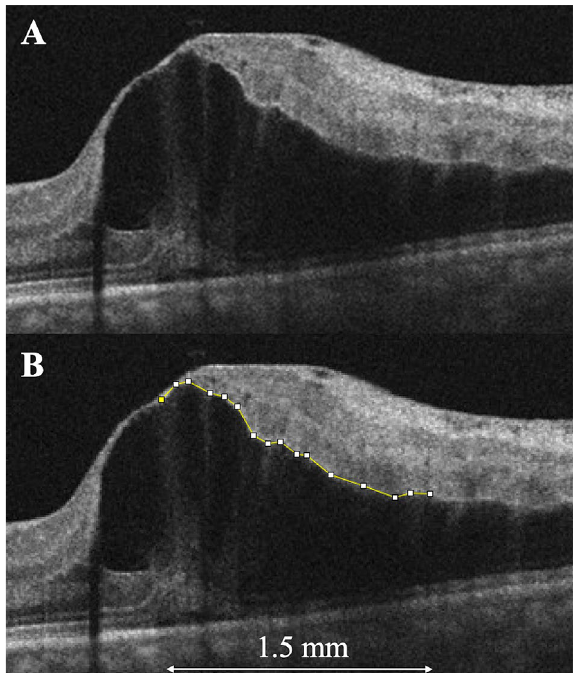
Figure 3. A spectral-domain optical coherence tomography (OCT) image of an eye with branch retinal vein occlusion of a 77-year-old woman who required only one anti-vascular endothelial growth factor injection over 1-year follow-up period. ( A ) An OCT image that ran vertically through the fovea at the initial visit shows macular edema, with large cystoid spaces in the outer plexiform layer (OPL). ( B ) The border between the inner nuclear layer and OPL is relatively smooth (segmented line). In this case, the jagged ratio is 1.01. Figure is created using ImageJ software version 1.53a (National Institutes of Health, Bethesda, Maryland, USA, available at https:// imagej. nih. gov/